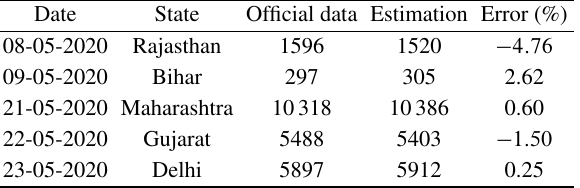
Fig. 7 Results of K-fold cross-validation. Table 6 Comparison of total reported and estimated confirmed cases.